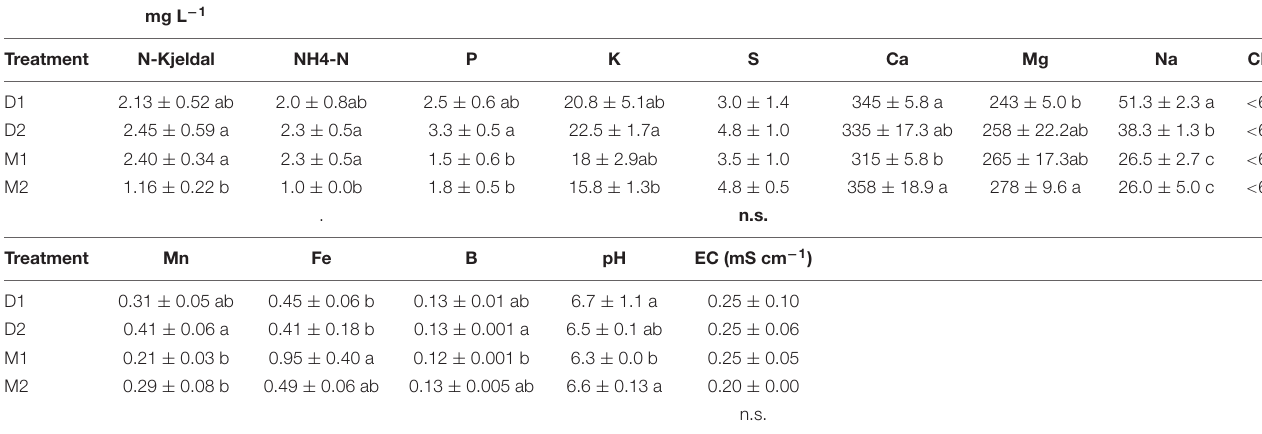
TABLE 7 | Plant-available nutrients in mg L − 1 growing medium. mg L − 1